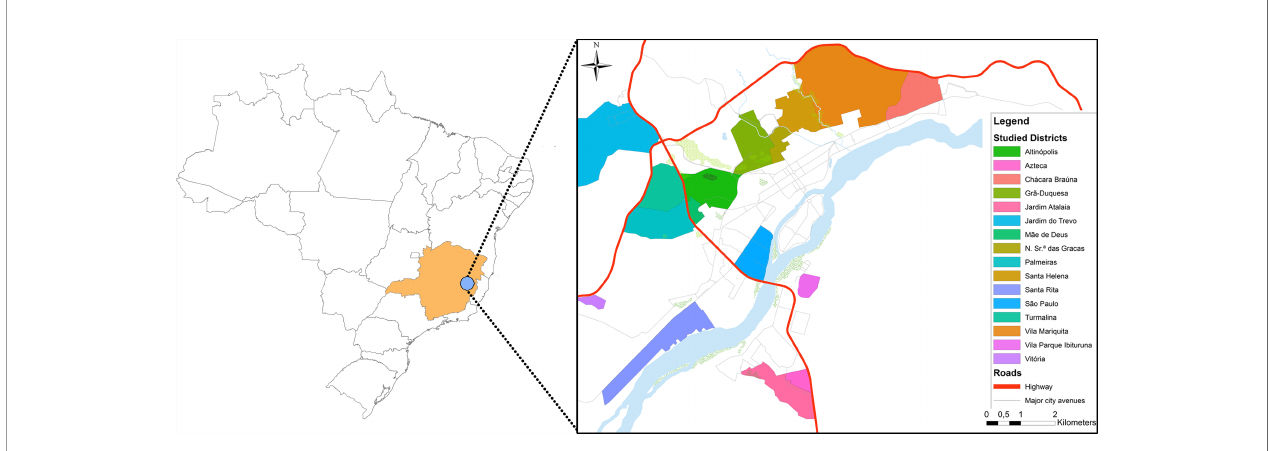
FIGURE 1 | Map of the city of Governador Valadares. On the left the inset shows the location of the Minas Gerais State in Brazil in orange and the city of Governador Valadares City as a blue point. On the right we show a city map with the neighborhoods where isolates were